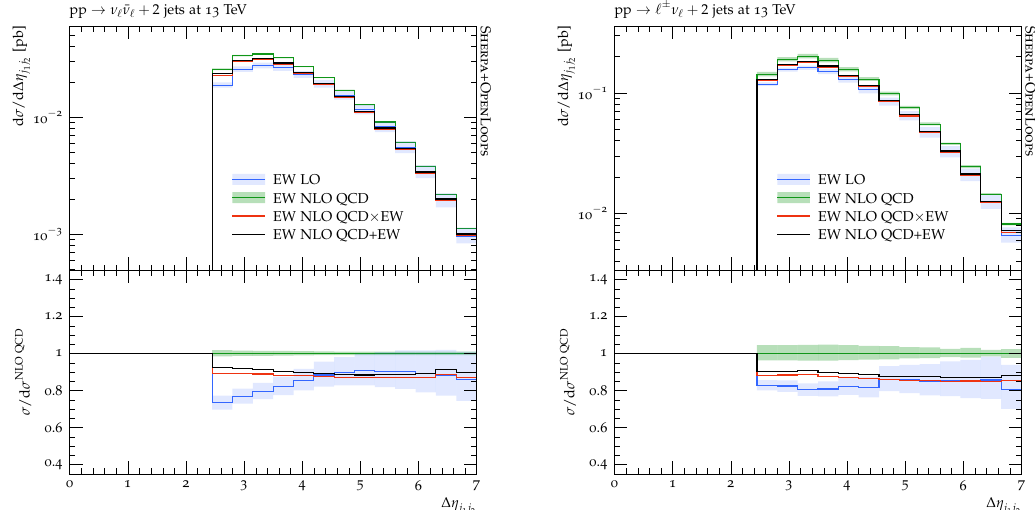
Figure 11. Distribution in the rapidity separation of the two hardest jets, ∆ η j pp → Z ( ν ‘ ¯ ν ‘ )+2 jets (left) and EW pp → W ± ( ‘ ± ν ‘ )+2 jets (right). Curves and bands as in figure 6. which plays the role of one of the two hardest jets. Their non-universality is due to the fact that the QCD corrections to W ± Z production are much larger as compared to W + W − and ZZ production. Both mechanisms tend to enhance W ± ( ‘ ± ν